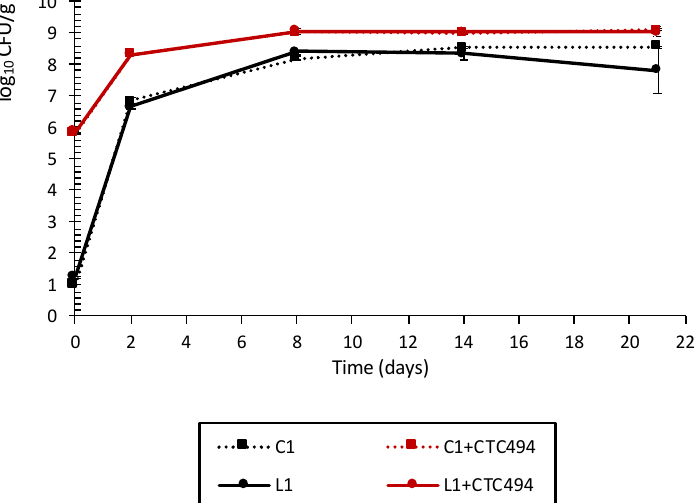
Figure 1. Growth of LAB in spontaneously fermented pork sausages with (L1) or without (C1) the addition of 5% of cava lees or fermented with the starter culture L. sakei CTC494, with (L1 + CTC494) or without (C1 + CTC494) cava lees.